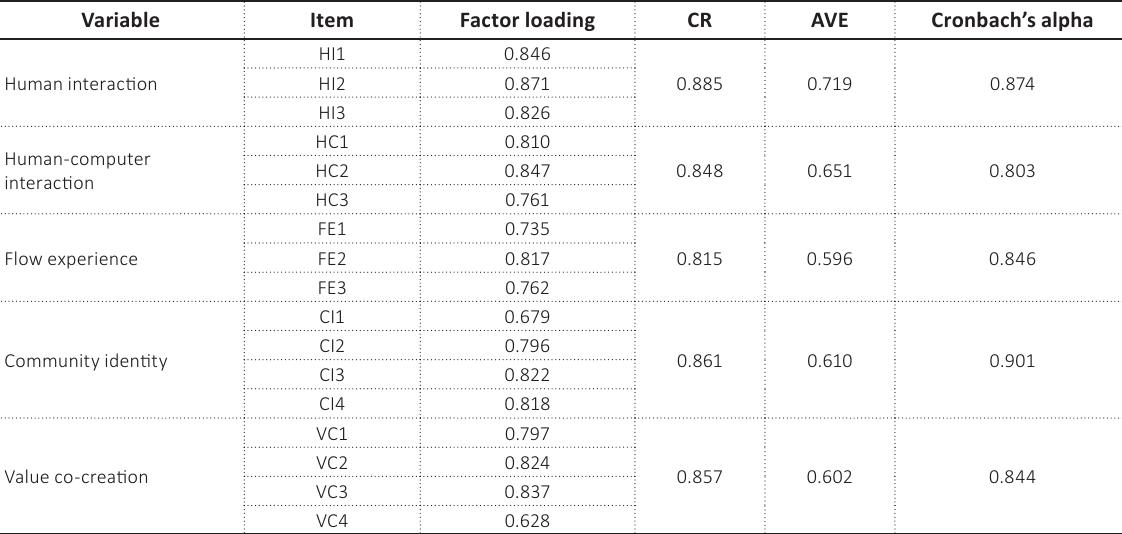
Table 1. Reliability analysis and convergent validity analysis